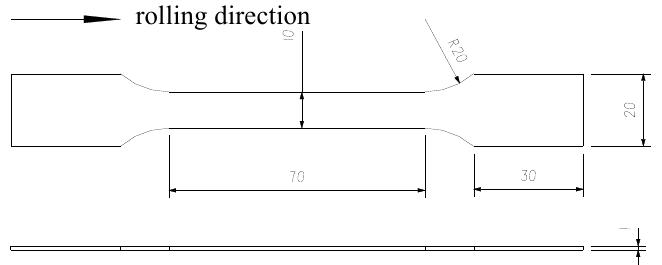
Figure 3. Geometry of test specimen for uniaxial tensile test in mm. The stress-strain response of AA6016 and AA5182 is expressed in Figure 4. The stress- strain response are fitted by power function and the adjusted R-squared is greater than 0.995. The fitting results are expressed in Table 1 and Figure 4. Table 1. Material parameter of AA6016 and AA5182.